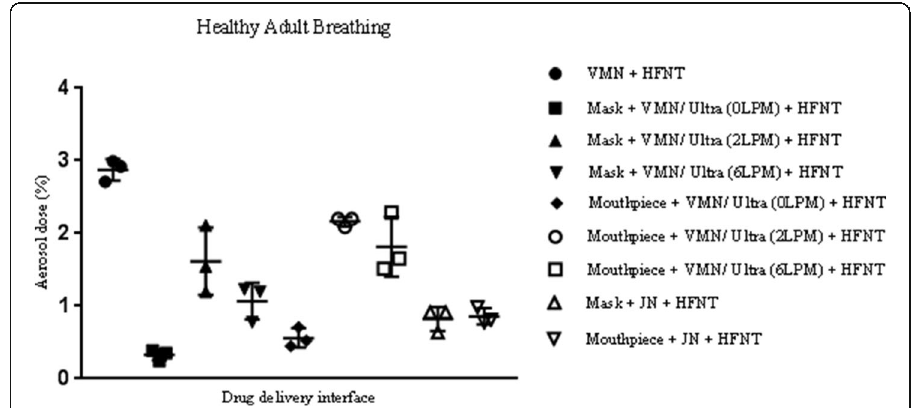
Fig. 4 Illustration of aerosol dose (percentage) for each delivery modality with concurrent HFNT, during simulated healthy adult breathing. The values represented are mean ± standard deviation (expressed in percentage) of three independent